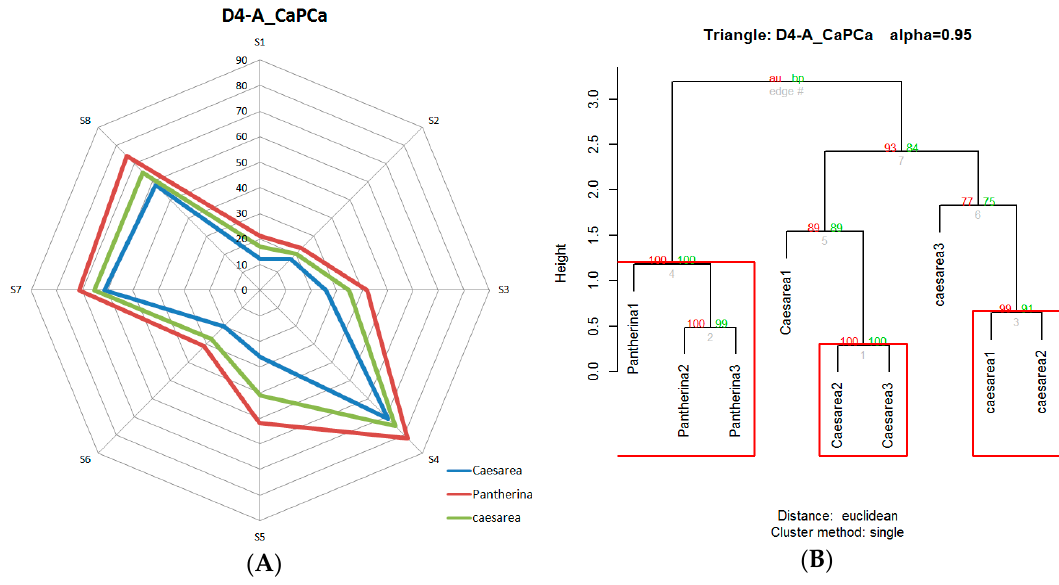
Figure 10. D4-A_CaPCa: the only triangle that did not reject null hypothesis in the hierarchical cluster analysis (HCA) analysis. ( A ) Radial graph; ( B ) dendrogram.